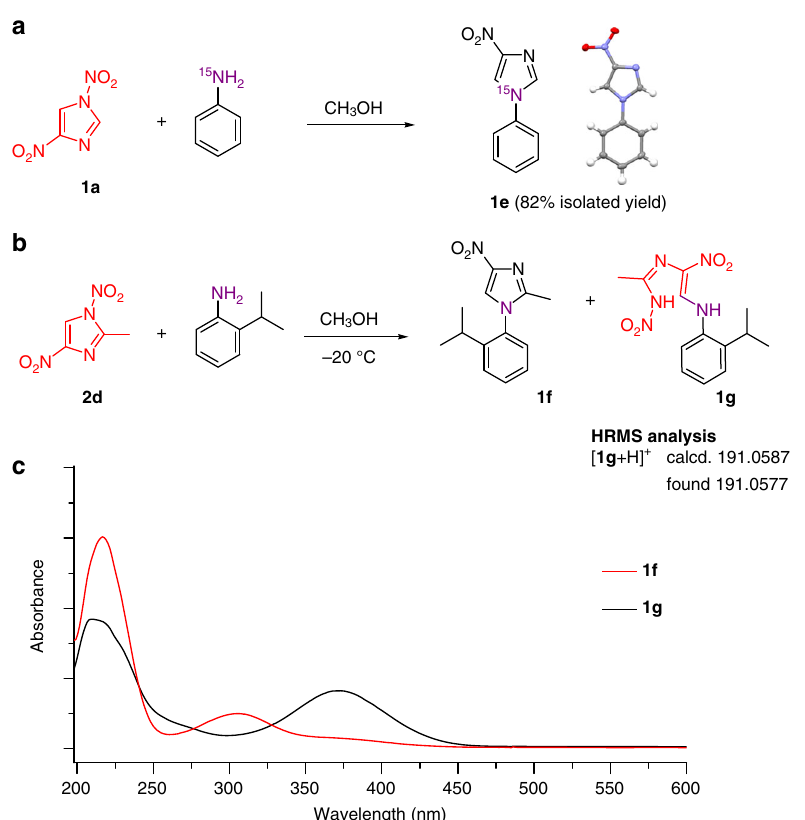
Fig. 5 Mechanistic investigation of the reactions between 1,4-DNIms and amines. a 1,4-DNIm 1a reacts with 15 N-labeled aniline to produce ( 1e ). The CCDC reference number of compound 1e is 1876959. HRMS (ESI) analysis of product ( 1e ): m / z calcd. for C 9 H 8 N 2 15 NO 2 [M + H] + 191.0587, found 191.0577; m / z calcd. for C 9 H 7 N 2 15 NNaO 2 [M + Na] + 213.0406, found 213.0400. b 2-isopropylaninline reacts with 2-methyl-1,4-DNIm 2d . HRMS (ESI) analysis of intermediate ( 1g ): m / z calcd. for C 13 H 17 N 5 NaO 4 [M + Na] + 330.1178, found 330.1172; c UV – Vis characterization of products 1f and